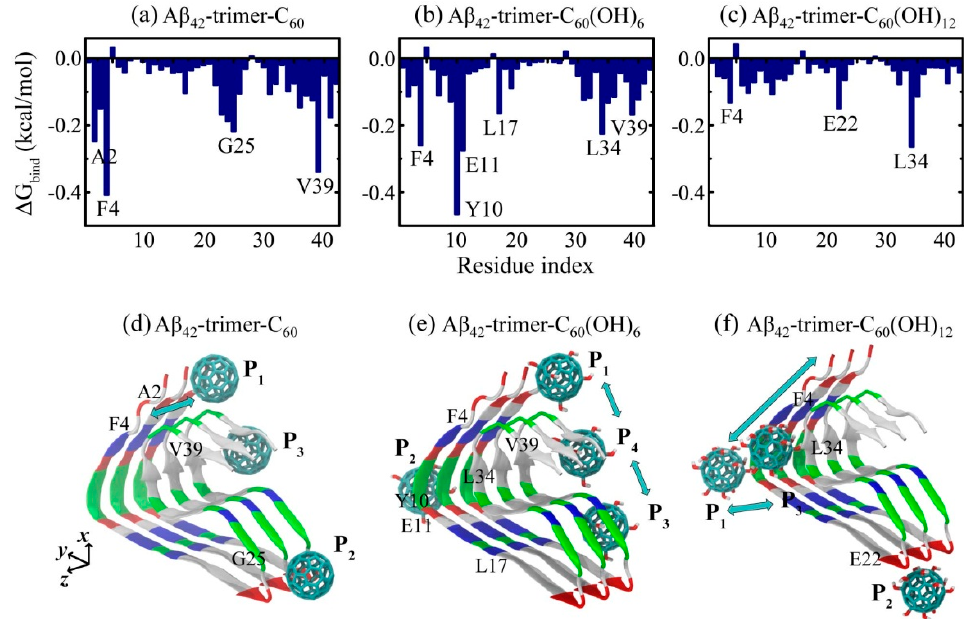
Figure 3. Analysis of binding sites of the fullerene/fullerenol molecule to A β 42 -trimer. ( a – c ) Residue-based binding free energy. The binding energy was calculated over all six MD runs for each simulated system using the last 20 ns data of each MD trajectory. ( d – f ) Schematic diagrams for binding sites of the fullerene/fullerenol molecule to A β 42 -trimer. The positions where the fullerene/fullerenol molecule has high binding affinity are named with P 1 , P 2 , etc., from N-termini to C-termini, and z -axis is the fibrillar elongation direction. The color code is consistent with that in Figure 1.